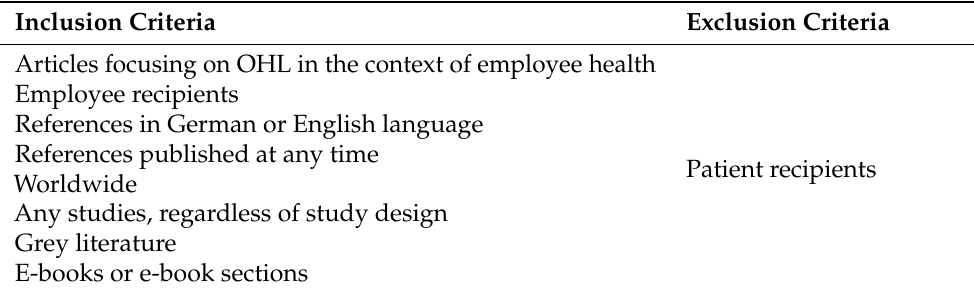
Table 2. Inclusion and exclusion criteria, RQ1.